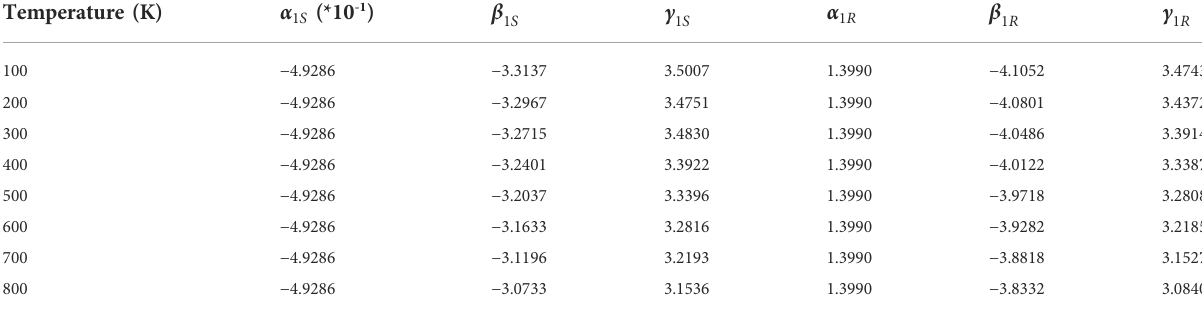
TABLE 1 Parameters for energy gap under strained and relaxed conditions in different